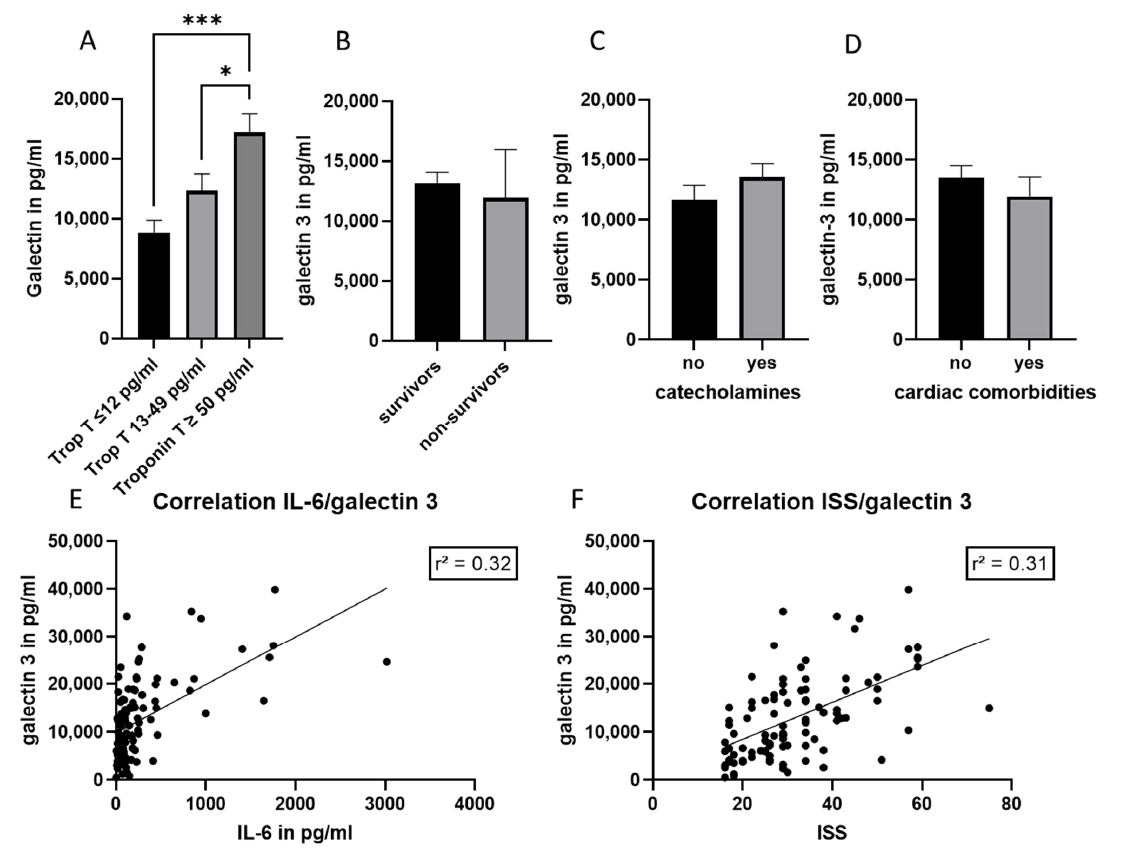
Figure 3. Galectin ‐ 3 concentration in different groups of polytrauma patients. ( A ) Galectin 3 con ‐ centration in the troponin T patients’ subgroups ( ≤ 12 pg/mL; between 13–49 pg/mL and ≥ 50 pg/mL). ( B ) Galectin ‐ 3 concentration in survivors and non ‐ survivors. ( C ) Galectin ‐ 3 concentration in patients with (yes) and without (no) need in catecholamines. ( D ) Galectin ‐ 3 concentrations in patients with and without cardiac comorbidities. ( E ) Correlation analysis between galectin ‐ 3 and IL ‐ 6 plasma con ‐ centrations. ( F ) Correlation analysis between galectin ‐ 3 plasma concentration and the injury severity score (ISS). n = 107 patients, * p ≤ 0.05; *** p ≤ 0.001.